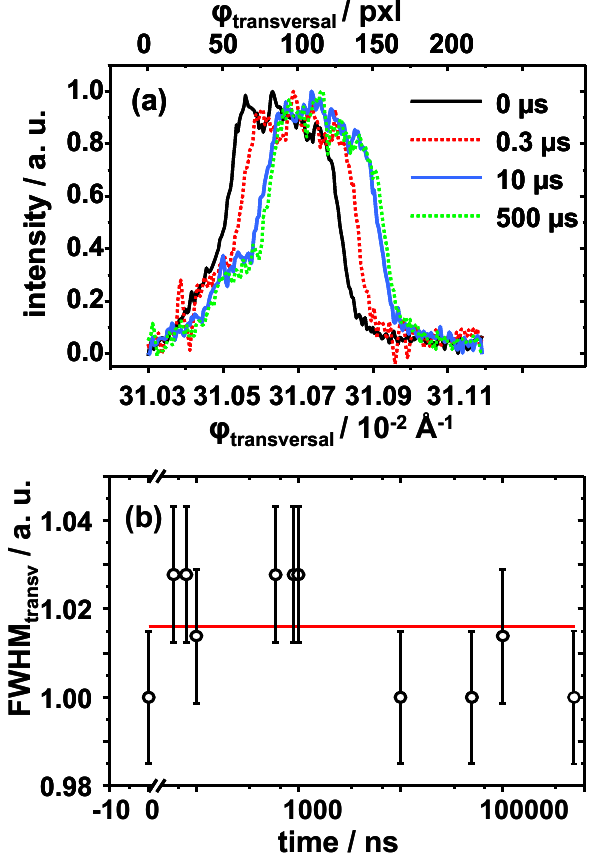
as a function of pixel transversal as a function of time. transversal